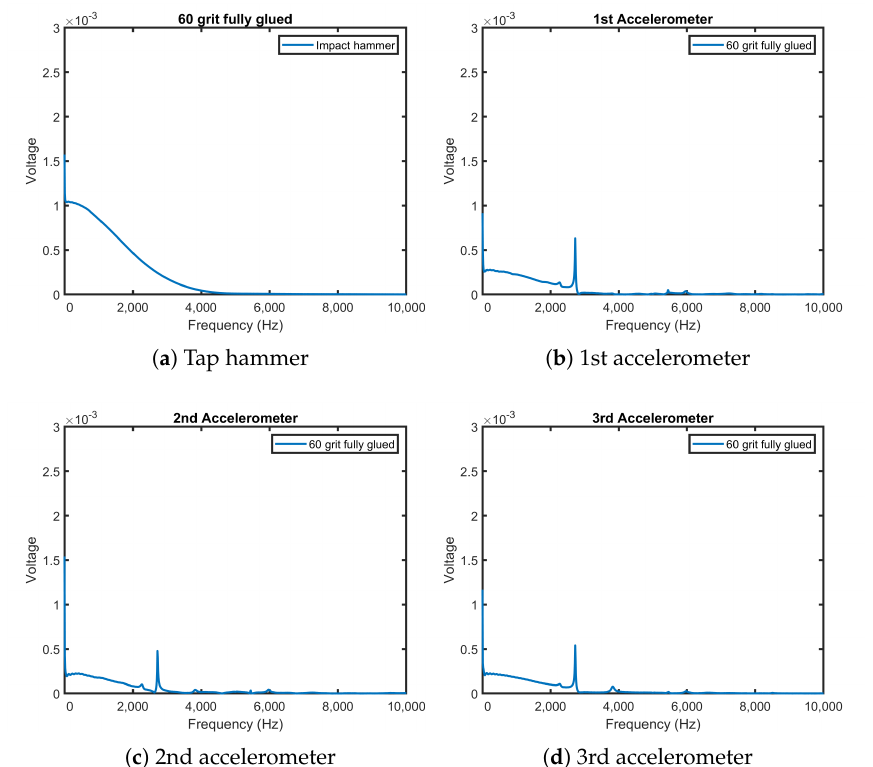
Figure 14. Typical natural frequency result of the fully glued 60 grit wheel.